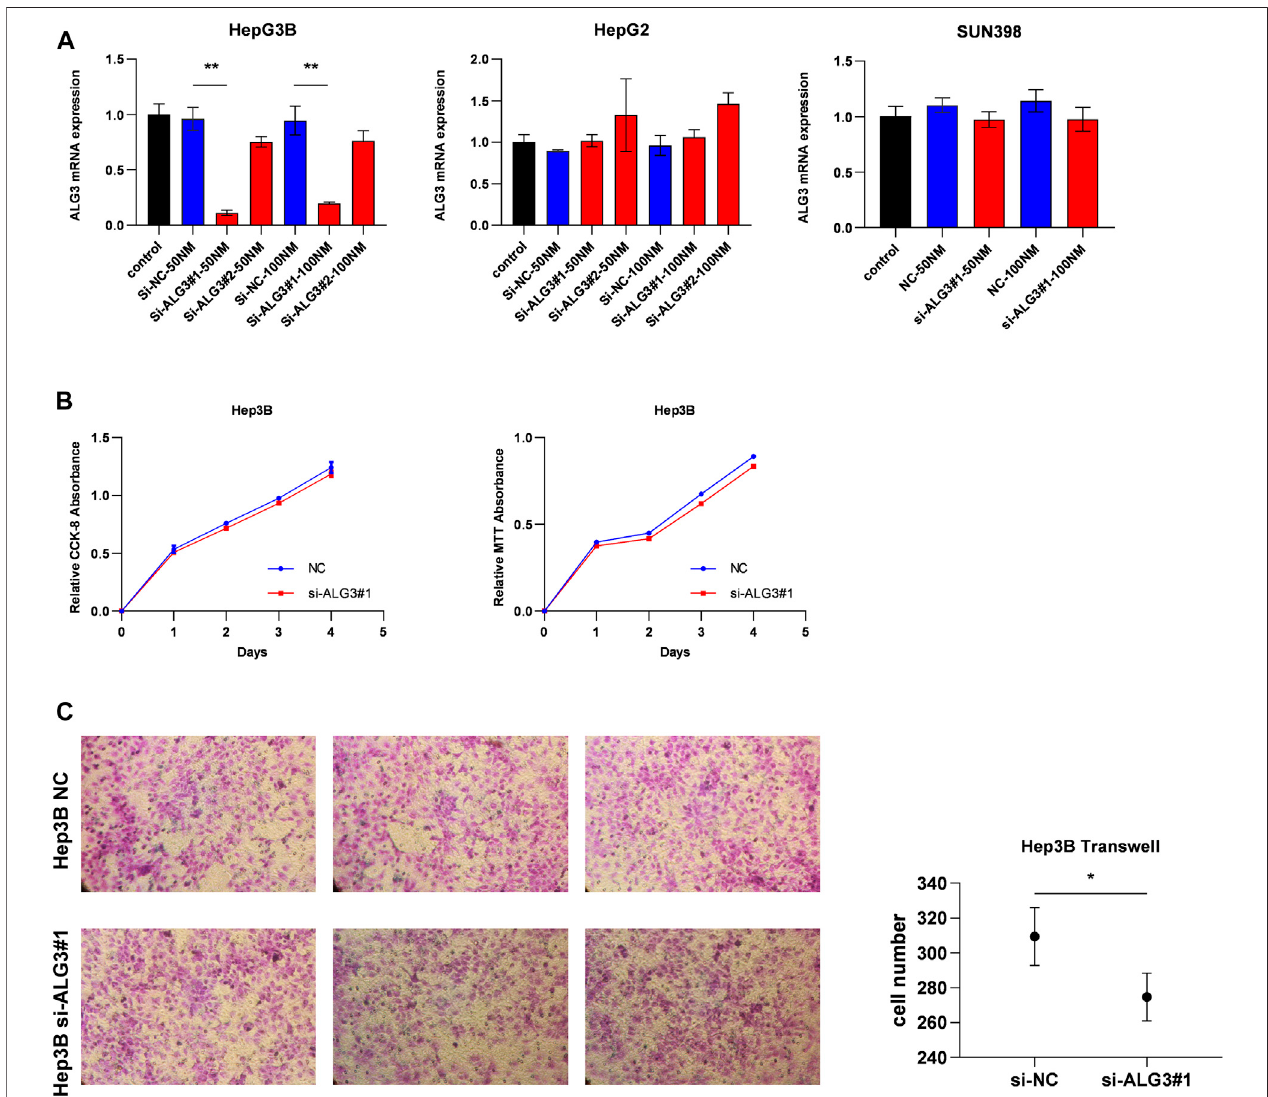
FIGURE 7 | ALG3 promotes HCC cell invasion. (A) Quantitation of the levels of ALG3 mRNA in HepG2, Hep3B, and SNU398 cells by qRT-PCR after transfection for 48 h with different siRNAs targeting ALG3 (si#1 and si#2) or a control siRNA. (B) CCK-8 and MTT assays evaluated the proliferation of Hep3B cells after the knockdown of ALG3. (C) Invasion number of Hep3B cells was decreased with ALG3 down-regulation. (* p < 0.05 and ** p < 0.01)